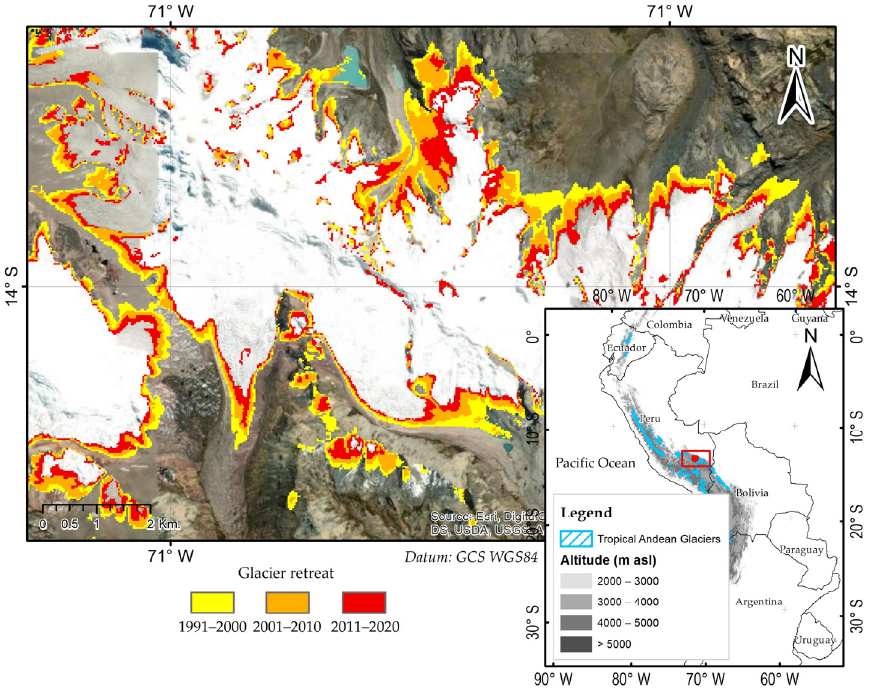
Figure 13. Map of glacier cover loss by decade from 1990 to 2020 in the Vilcanota Cordillera (mountain range) in southern Peru.